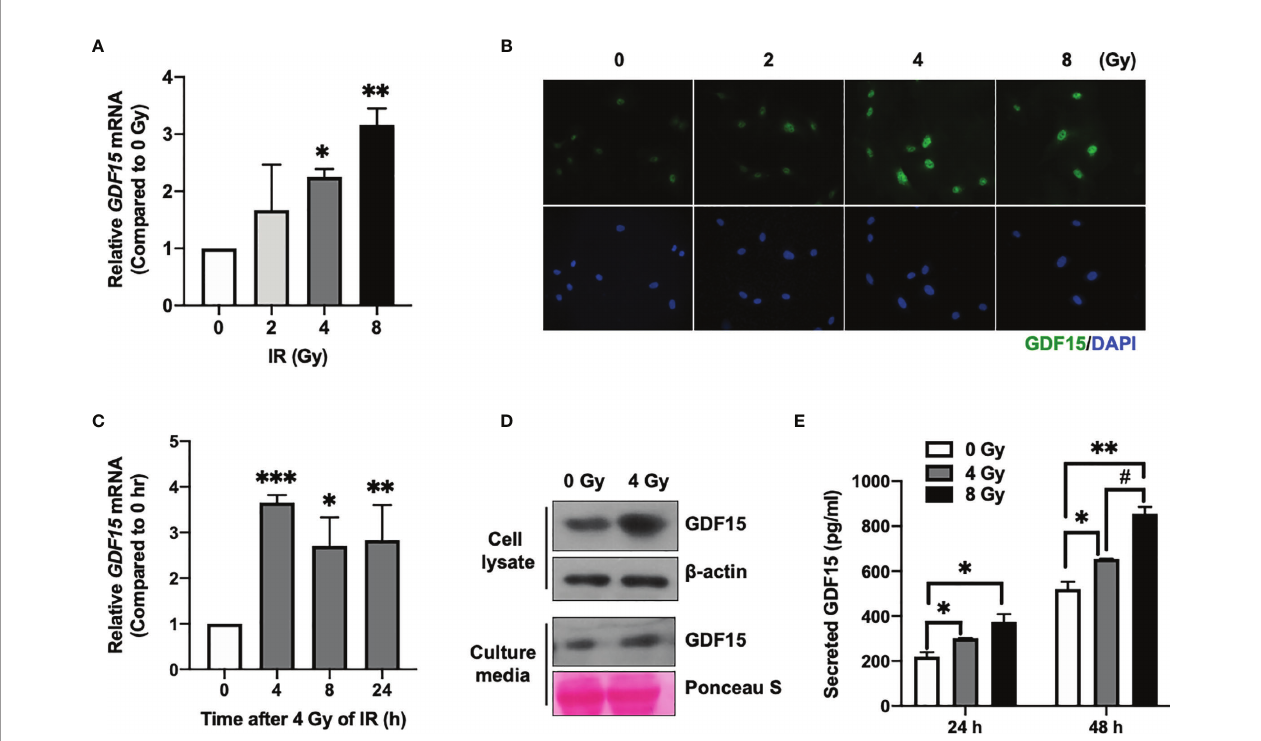
FIGURE 1 | Effect of ionizing radiation (IR) on GDF15 expression in human brain microvascular endothelial cells (HBMVECs). (A) Effect of different doses of IR on GDF15 mRNA expression in HBMVECs. Cultured cells were harvested 24 h post-IR exposure, and GDF15 mRNA levels were analyzed using quantitative reverse transcription polymerase chain reaction (qRT-PCR). (B) Effect of different doses of IR (0 – 8 Gy) on GDF15 protein levels in HBMVECs. GDF15 protein expression was detected by immuno fl uorescence analysis using anti-GDF15 antibody (green). Nuclei were stained with 4 ′ ,6-diamidino-2-phenylindole (DAPI) (blue) (Magni fi cation: 400×); (C) Time course of GDF15 mRNA expression after irradiation with 4 Gy of IR. GDF15 mRNA levels measured using qRT-PCR at the indicated time points. (D) Immunoblotting analysis of GDF15 in the cell lysate and culture medium reveals that IR upregulated GDF15 protein levels. Cells and culture media were harvested at 24 h post-IR exposure. (E) IR promotes the secretion of GDF15. The secretion of GDF15 into the culture medium was measured using a human GDF15 enzyme-linked immunosorbent assay kit at 24 and 48 h post-irradiation with 4 or 8 Gy of IR. Data are presented as the mean ± standard deviation of three experiments. * p < 0.05, ** p < 0.01, and *** p < 0.001 compared with the control. ## p < 0.05 compared with 4